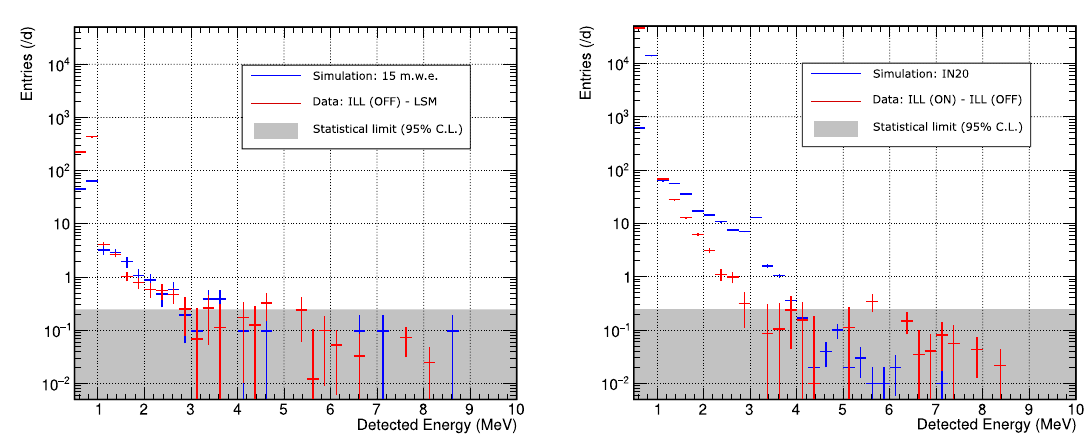
by subtracting the reactor OFF data, which subtracts both the resid- ual internal background contamination and the cosmogenic component within statistical uncertainties. All measurements at the ILL reactor were done with a 1 cm thick layer of boron-loaded rubber around the 3 Heproportionalcounter.Lastly,asdiscussedinSect.3,duetotheinter- nal proportional counter background, a statistically significant neutron contribution can be inferred from an observed rate larger than about 0.25 evt/day/bin at 95%